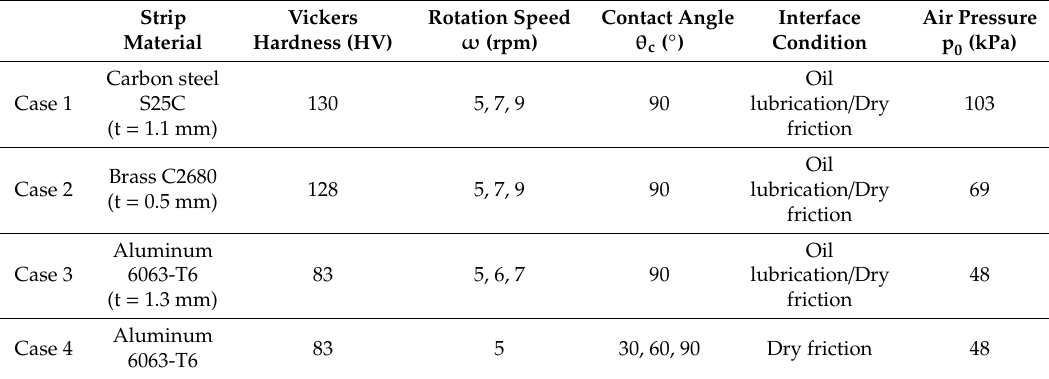
Table 1. Friction tests